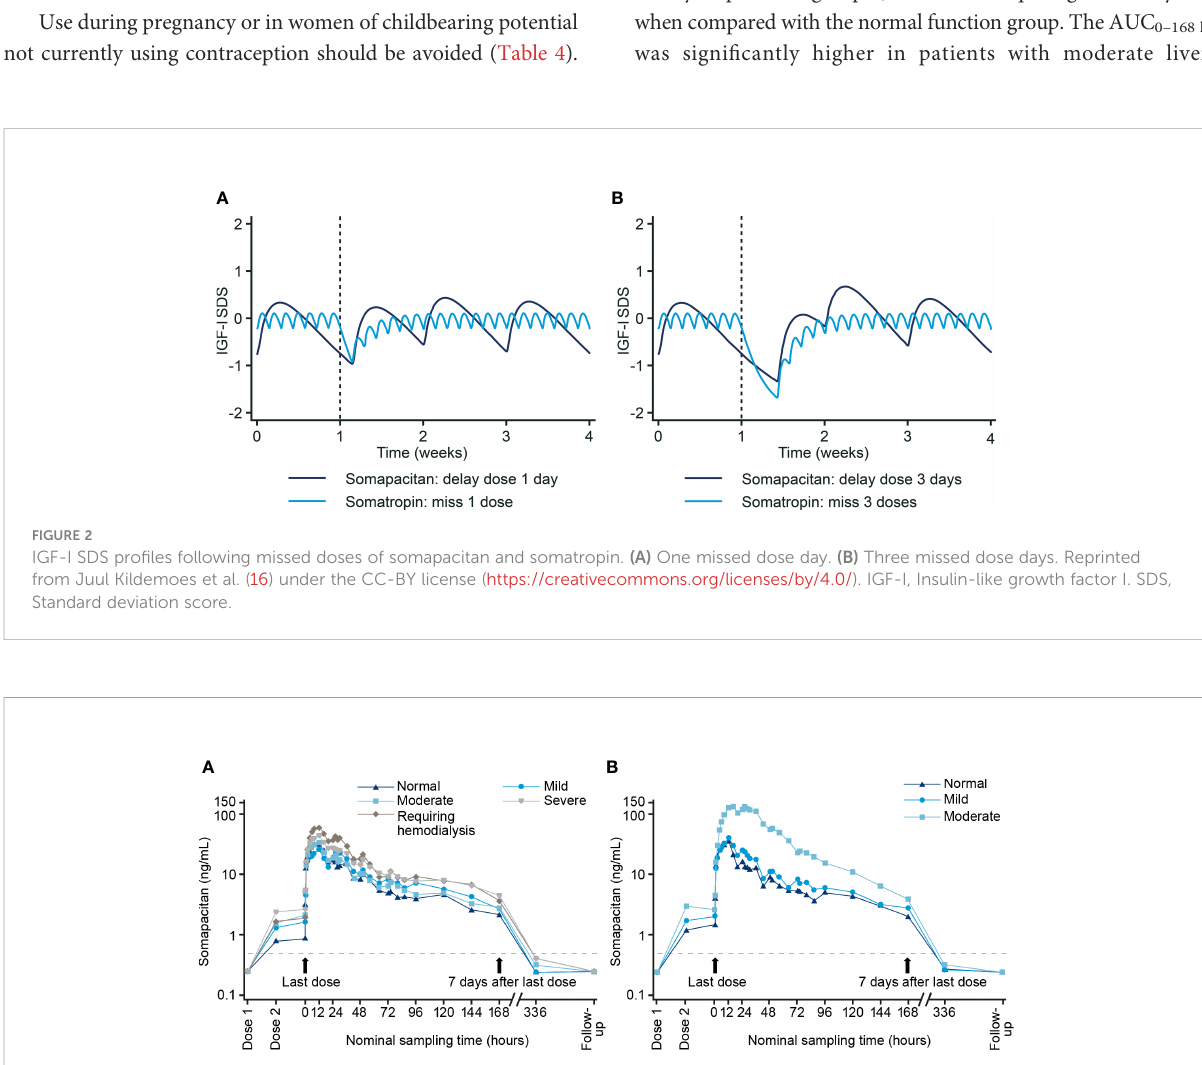
FIGURE 3 Geometric mean pro fi le for somapacitan in patients with impaired kidney/liver function. (A) Normal function group and four kidney impairment groups. (B) Normal function group and two hepatic impairment groups (mild/moderate). Reproduced with permission